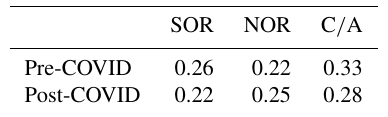
+ SO = NO − /( SO 2 − /( NO − 2 ) , NOR 4 4 3 3